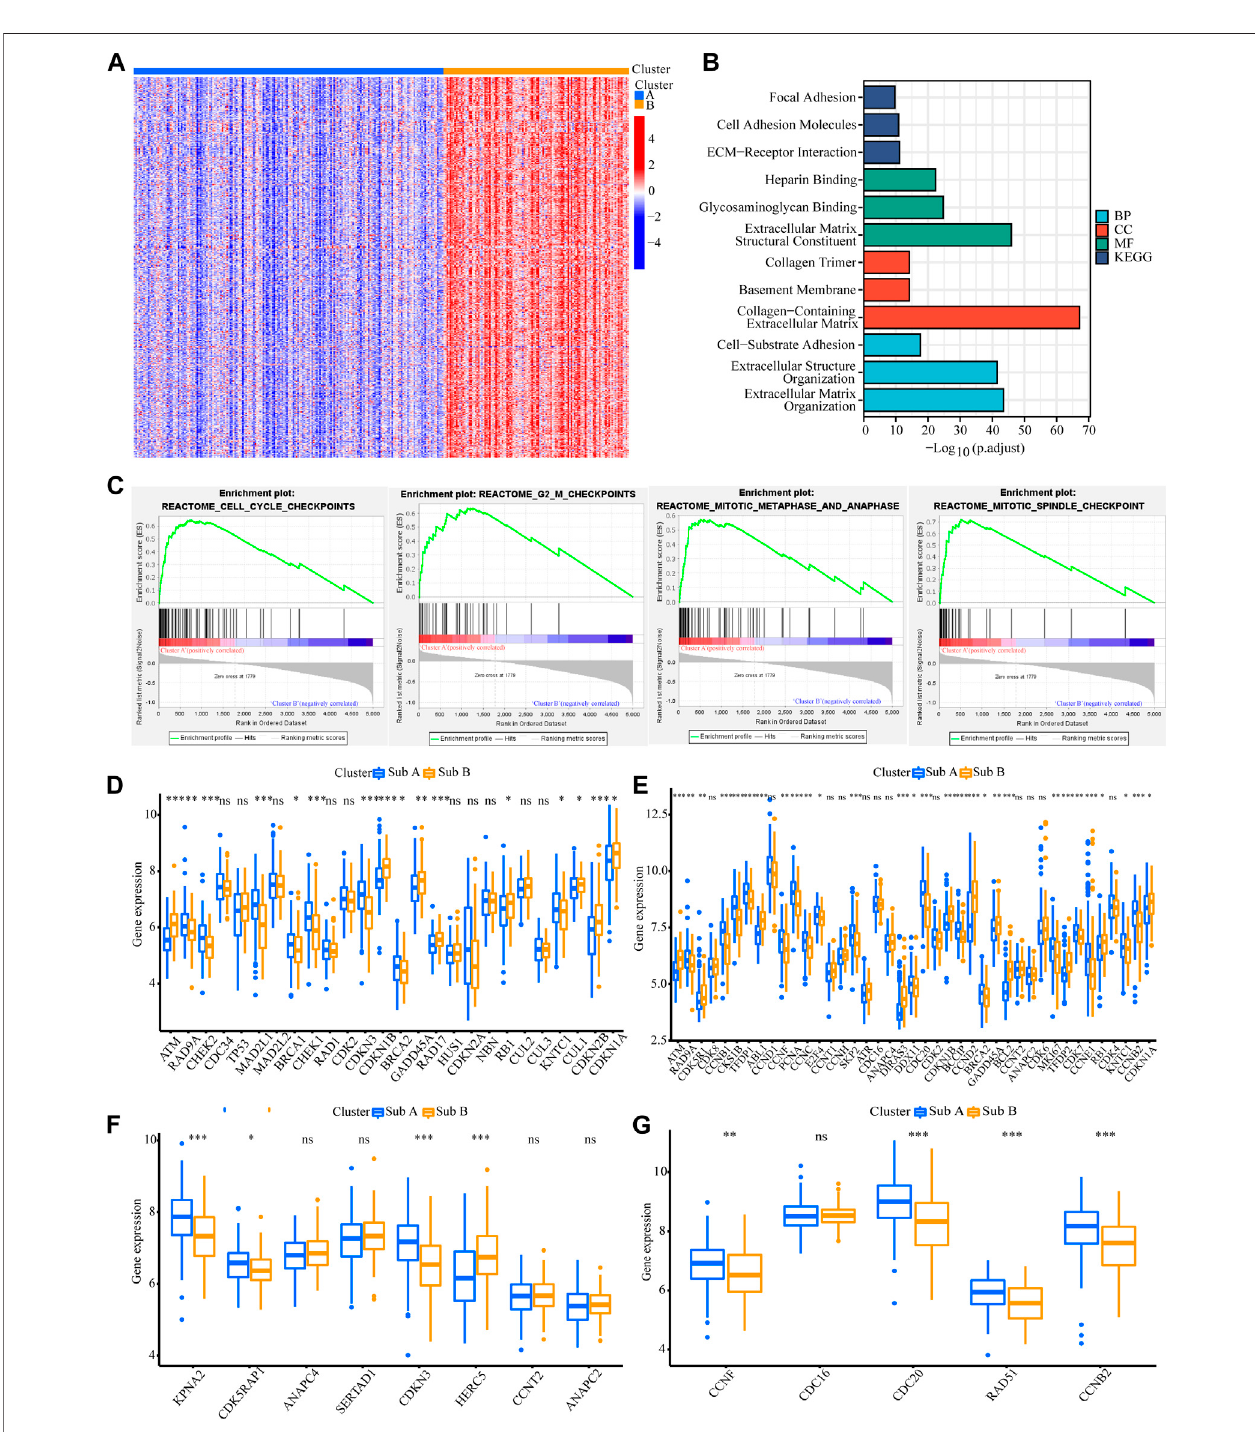
FIGURE 2 | Analyses of the biological functions of the two subtypes in the TCGA cohort. (A) The heatmap showed DEG between Sub A and Sub B. (B) GO and KEGG analyses on upregulated genes in Sub A vs Sub B in TCGA cohort. (C) GSEA analysis of the two subtypes in the TCGA cohort. (D – G) A box plot showed the difference in the expression of cell cycle checkpoint (D) , cell cycle G2/M phase transition (E) , negative regulation of nuclear division (F) and regulation of spindle checkpoint (G) between the two subtypes. * p < 0.05; ** p < 0.01; *** p < 0.001.